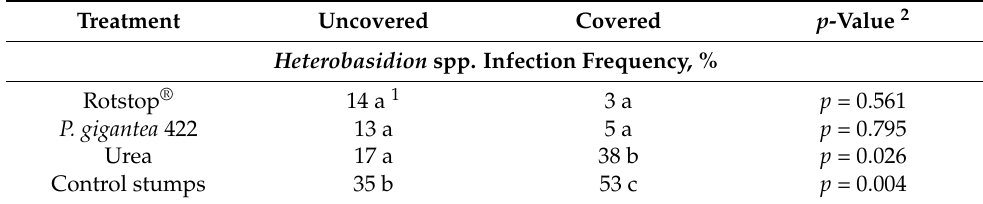
Table 2. Mean infection frequencies (%) of Heterobasidion spp. in Norway spruce stumps and percent of stump surface colonized by Heterobasidion spp. and P. gigantea treated with Rotstop ® , native Latvian Phlebiopsis gigantea strain or urea (% ± standard deviation). Treatment Uncovered Covered p -Value 2 Heterobasidion spp. Infection Frequency, % Rotstop